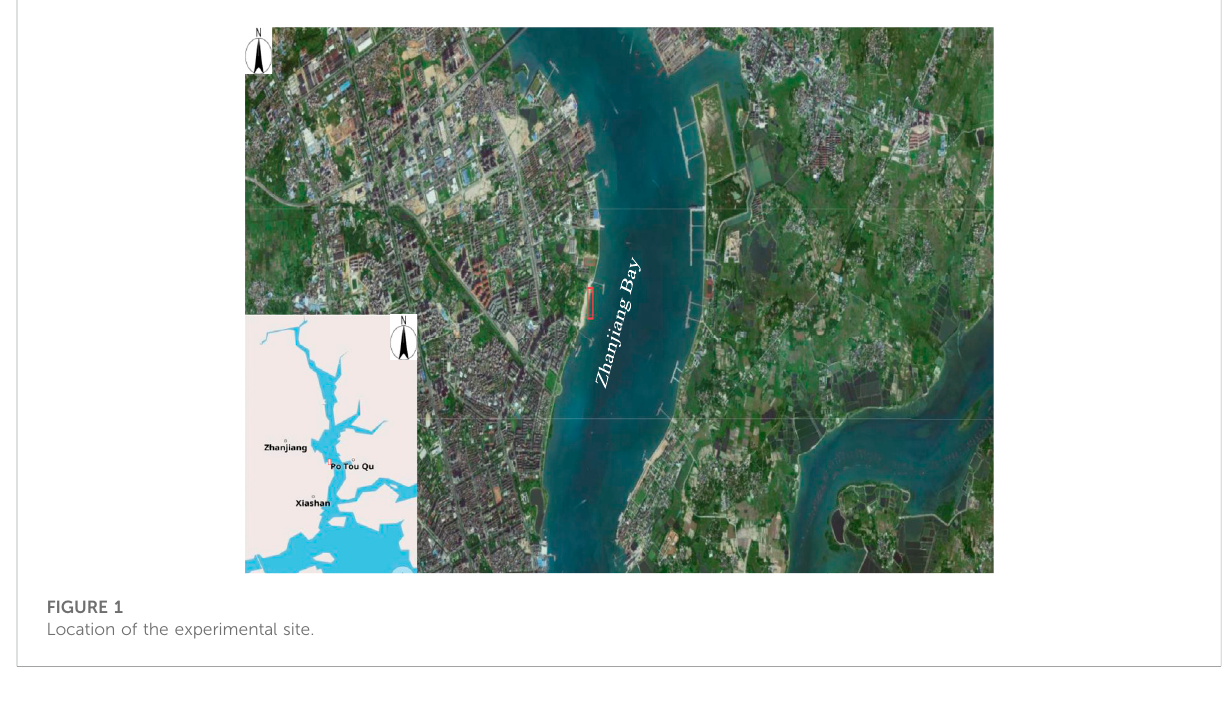
FIGURE 1 Location of the experimental site.